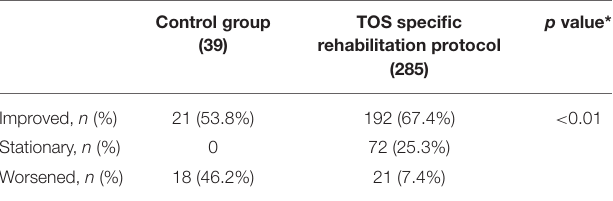
TABLE 3 | Symptoms variation in patients undergoing a specific rehabilitation protocol vs. those refusing treatment at the last available follow-up visit. Control group TOS specific (39) rehabilitation protocol